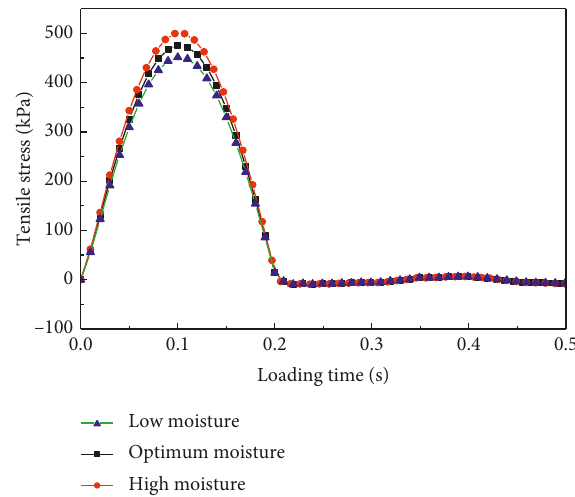
Figure 8: Effect on tensile stress at the bottom of surface